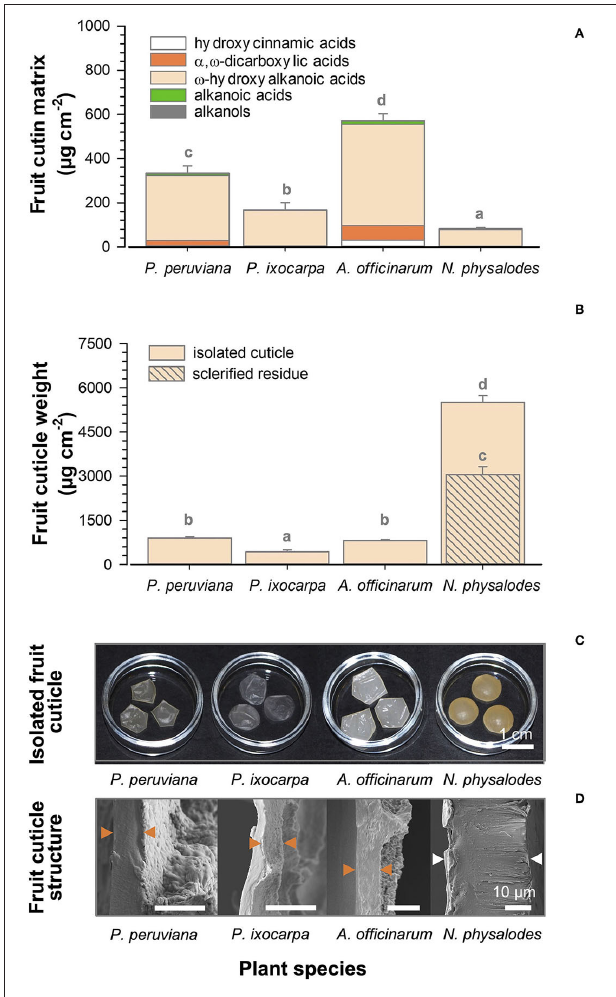
FIGURE 6 | Gas chromatographic analysis of cutin deposition of Physalis , Alkekengi, and Nicandra ripe fruits subdivided into compound classes of cutin monomers (A) . Gravimetric data of enzymatically isolated fruit cuticle and the non-extractable, non-hydrolysable residue (B) . Data are shown as mean ± SD ( n ≥ 4). Different letters indicate significant differences between plant species ( p < 0.05). Photographs of enzymatically isolated fruit cuticle (C) . Scanning electron micrographs of cross-sections of isolated fruit cuticles. Arrowheads indicate the isolated fruit cuticle (orange) or the isolated fruit cuticle plus a layer of sclerified cells (white; D